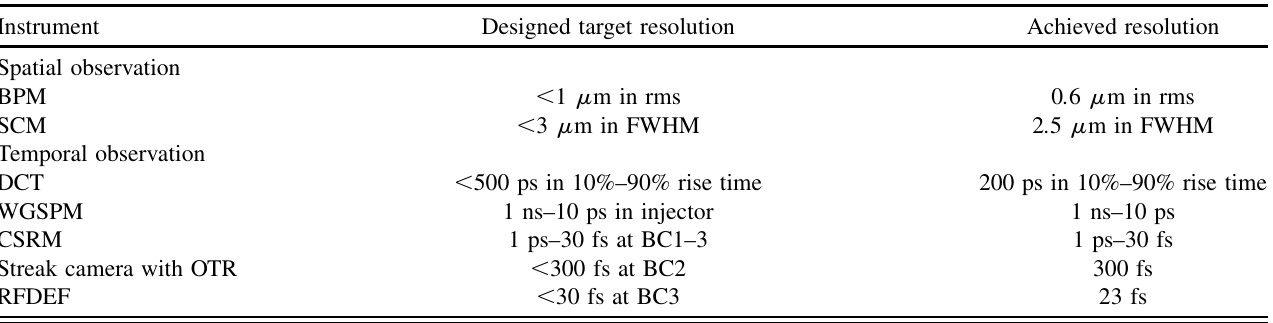
TABLE III. Achieved spatial and temporal resolutions of the individual beam monitors and their design resolutions. Instrument Designed target